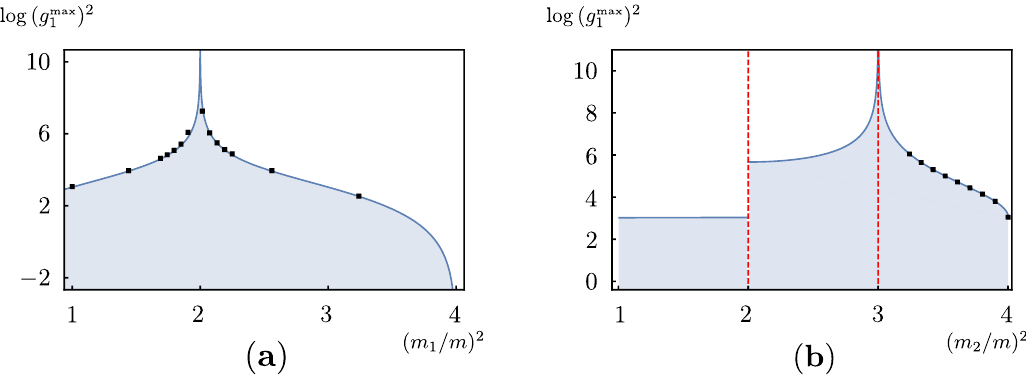
Figure 14 . Maximal coupling g max for (a) a single exchanged particle of mass m 1 and (b) a 1 particle of mass m 1 = m plus an heavier particle of mass m 2 . The solid blue lines are the an- alytic results of the two dimensional S-matrix bootstrap. These are nothing but the top right and top left slices of the more general (cid:12)gure 10. The black squares are the outcome of the one dimensional conformal bootstrap numerics from [8]. These numerics are obtained using SDPB in (a) and JuliBootS in (b) [26{28]. In either case, within the precision of the numerics, the agree- ment with the analytic result is striking. It is worth emphasizing that the solid curves are very non-trivial functions. The right-most branch of (b), for instance, corresponds to the analytic re- p 3 x ( x 2 sult ( g max ) 2 = 12( x (6 p 4 x 2 4)) + 3 p 3) = ( x 4 4 x 2 + 3) with x = m 2 =m 1 (cid:0) (cid:0) (cid:0) (cid:0)